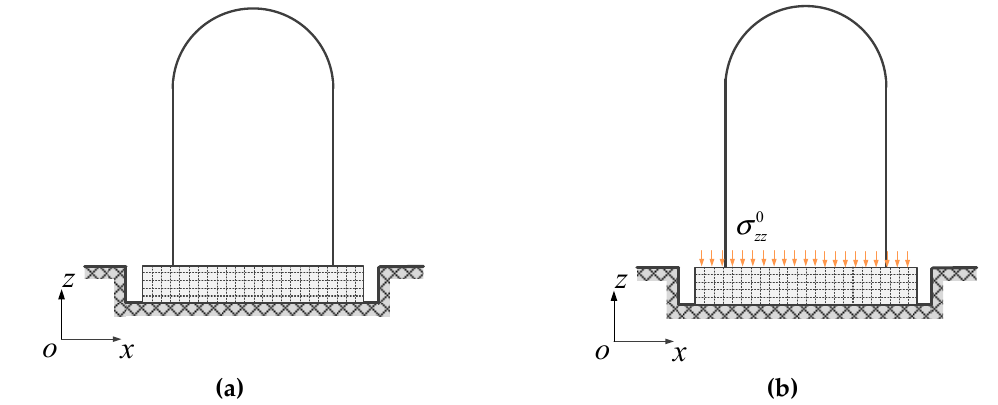
Figure 8. 2D periodic foundation ( a ) without and ( b ) with considering the effect of vertical load.